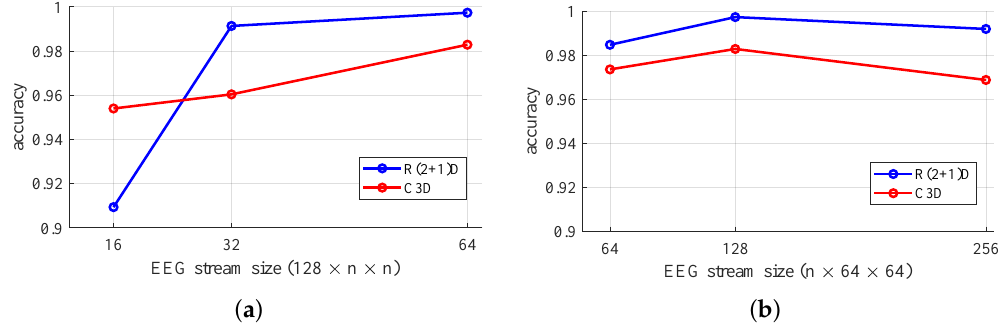
Figure 8. Classification accuracies of 4-class classification with different sized 3D EEG streams. ( a ) the results of various spatial resolutions of the 3D EEG stream; ( b ) the results of various temporal resolutions of the 3D EEG